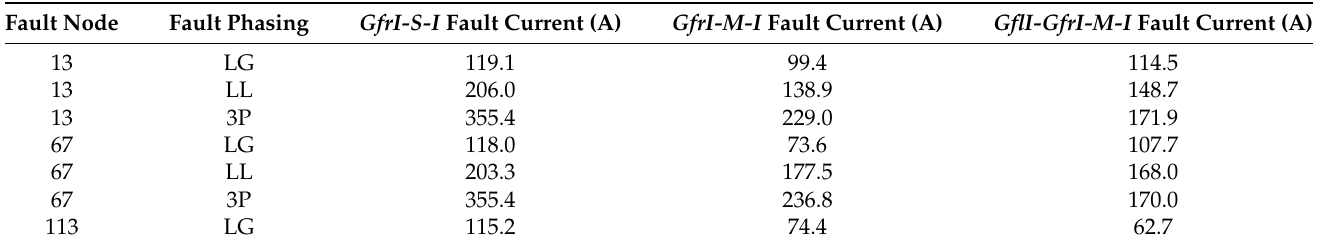
Table 7. Comparison of results for configurations GfrI-S-I, GfrI-M-I, and GflI-GfrI-M-I of the IEEE 123-Node System, and 20 Ω fault resistance.